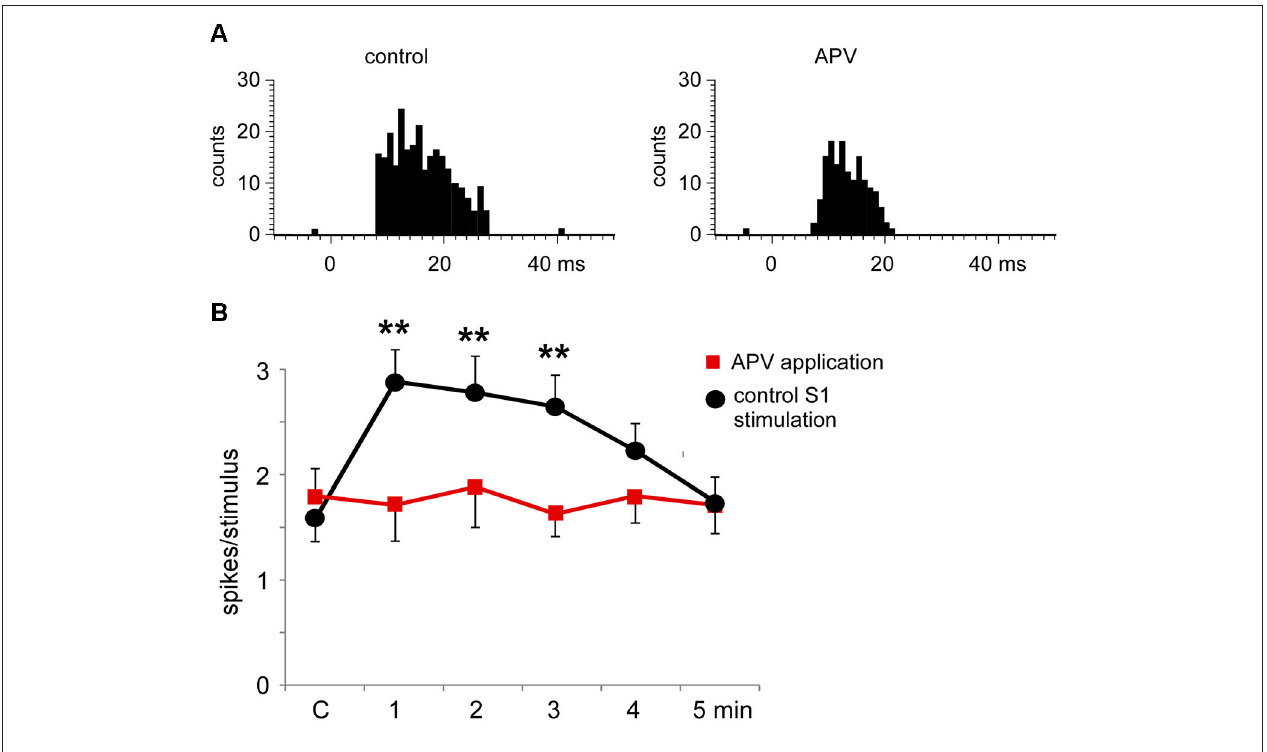
of a SI stimulation train in a matched condition. In the presence of APV ( n = 14 cells; red squares) the long-lasting facilitation evoked by corticofugal stimulation was blocked in comparison to responses after the application of saline solution ( n = 8 cells; black circles). ** P < 0.01 statistical significance after cortical stimulation train with respect to control